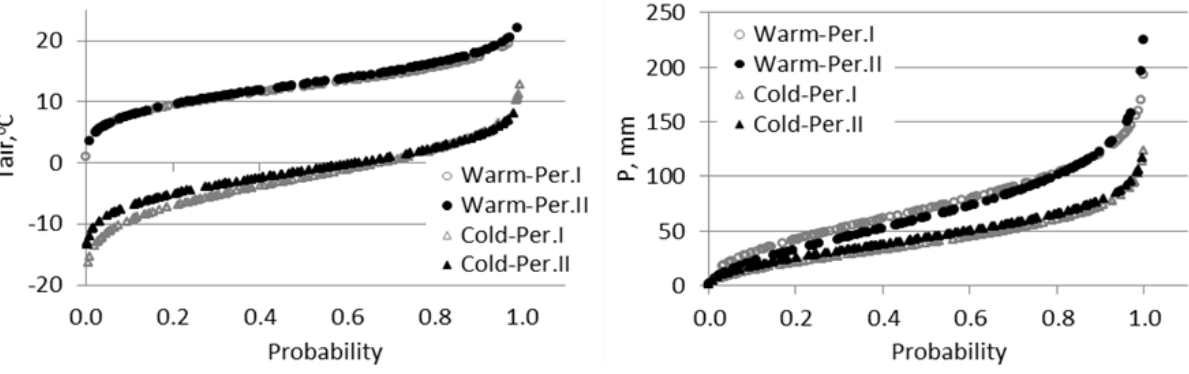
Figure 5. Probability plots of air temperature (T Periods I and